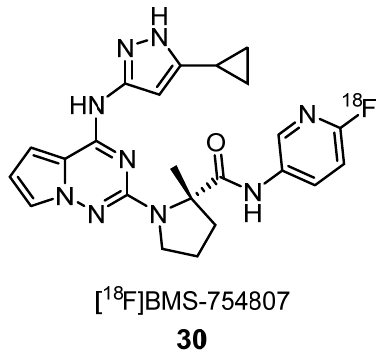
Figure 12. Potential PET radiotracer 30 for IGF ‐ IR imaging [56].